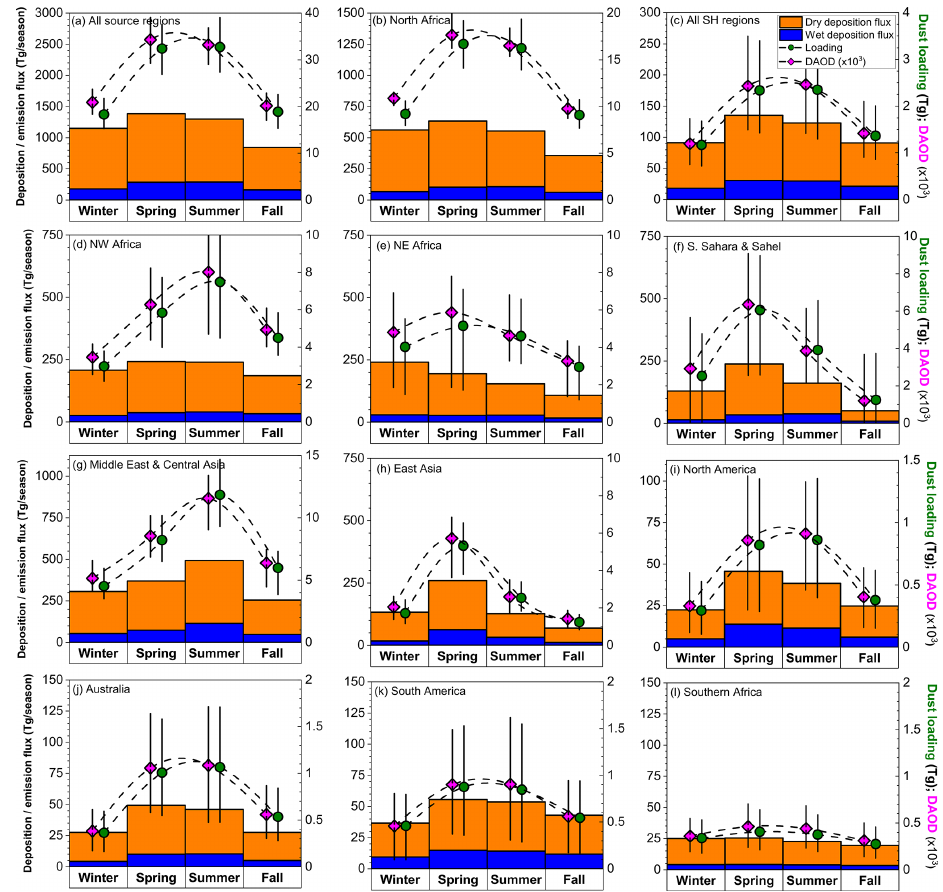
Figure 4. Seasonal contributions of each source region to the global dust cycle. Shown are the seasonal cycles of the wet deposition flux (blue bars and left axis), dry deposition flux (orange bars and left axis), dust loading (green circles and right axis), and DAOD (magenta diamonds and right axis) generated by (a) all source regions, (b) all North African source regions, (c) all Southern Hemisphere source regions, and (d– l) each of the nine individual source regions. The sum of the seasonal wet and dry deposition fluxes is approximately equal (within a few percent) to the seasonal dust emission flux generated by each source region. Results for loading and DAOD are slightly offset horizontally for clarity. Seasons refer to boreal seasons for global results (a) and to local seasons for all other panels. Note that the vertical axis scale differs between source regions. Error bars denote 1 standard error from the median; error bars on deposition fluxes usually exceeded 100% and are not included for